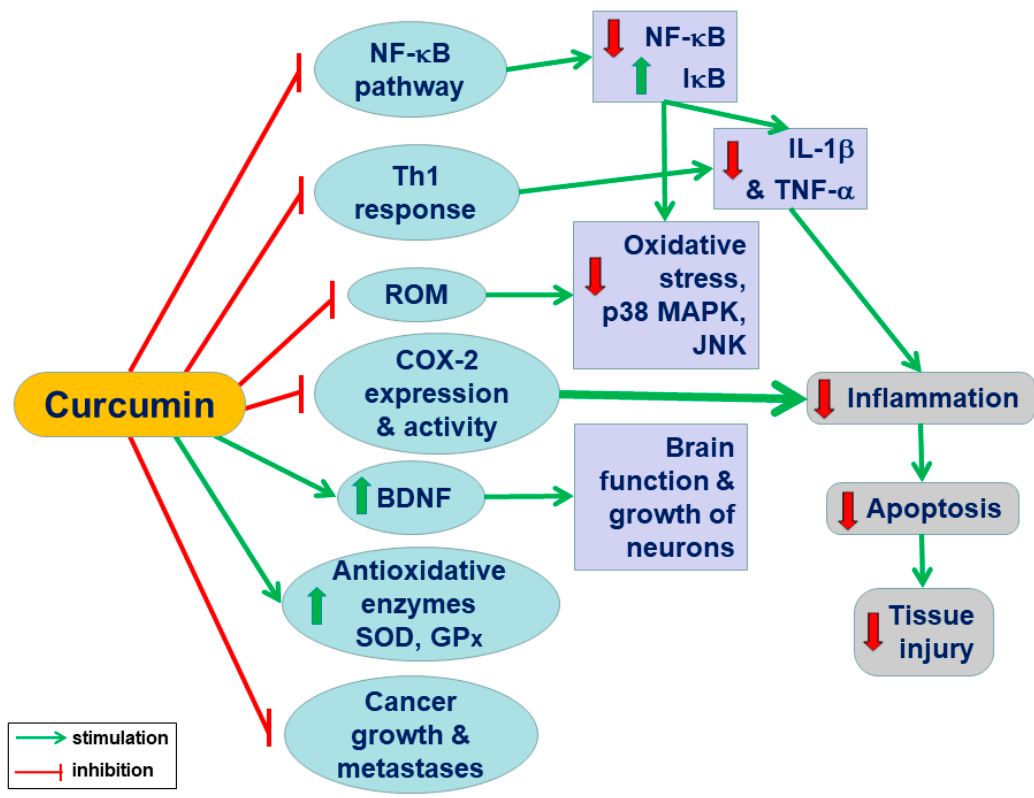
Figure 1. A conclusive summary of the pleiotropic action of curcumin in the body system: Curcumin exhibits anti-inflammatory, antioxidant, antiapoptotic, antitumor, and antimetastatic activities and suppresses multiple signalling pathways responsible for inflammation, apoptosis, and cellular death. Curcumin improves the growth of neurons and the functions of the brain in addition to the downregulation of reactive oxygen species, oxidative stress, and proinflammatory factors (NF- κ B and cytokines).